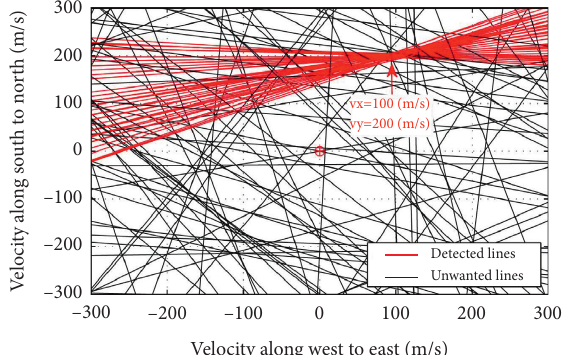
Figure 9: Constant velocity equation map.